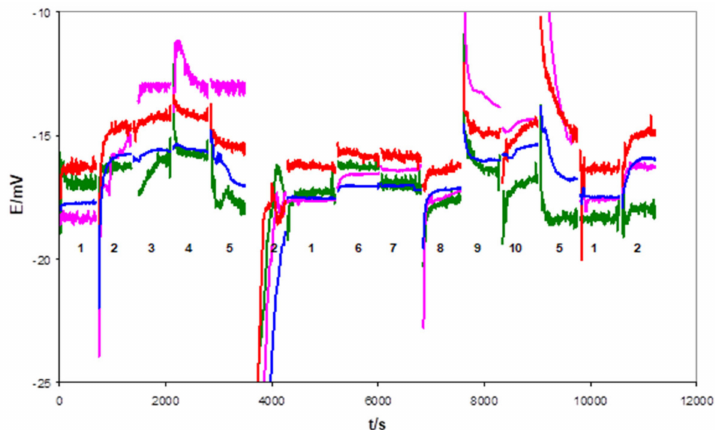
Figure 3. Potential changes of the 1c type electrodes recorded during multi-solution testing subse- quently performed in indicated solution: 1—3 M KCl, 2—H 2 O, 3—0.01 M NaCl, 4—0.01 M KCl,